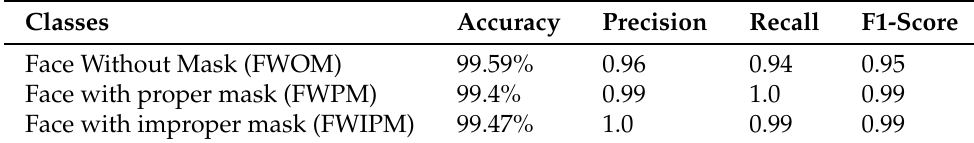
Table 7. Statistics using ResNet-50 by classes.